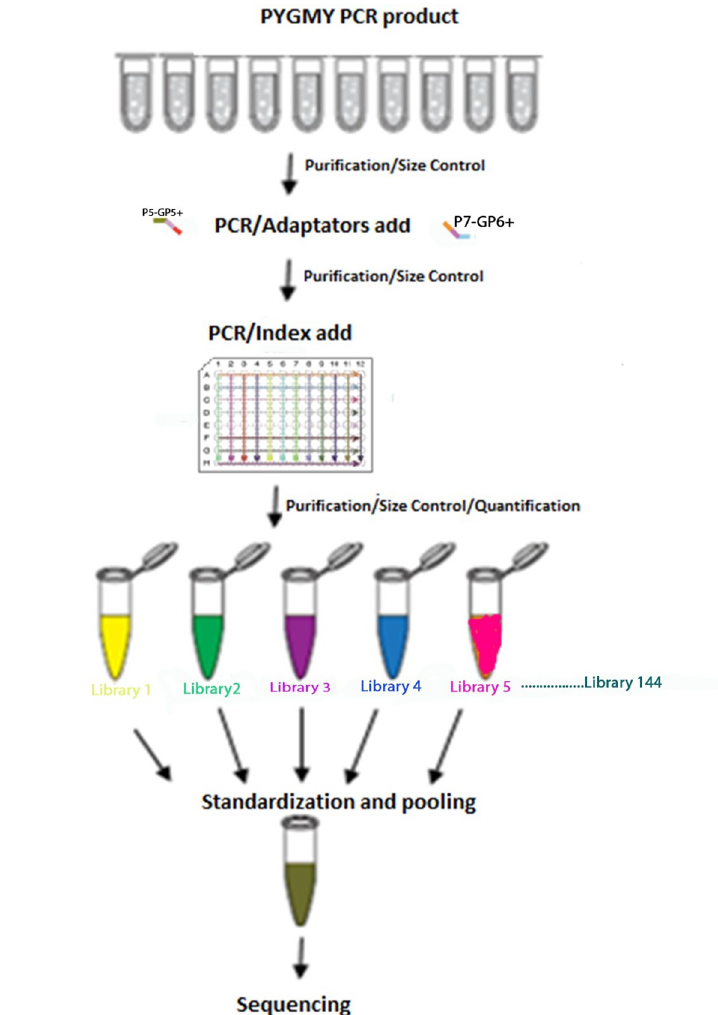
Fig 1. Workflow for library preparation and sequencing. Amplicons generated through a PGMY PCR were amplified using customized primers containing Miseq specific adaptors then indexation and pooling were done before sequencing using Miseq